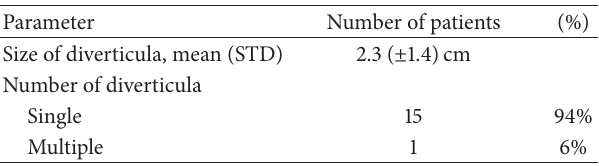
Table 2: Radiographic data for women undergoing surgical resec- tion of urethral